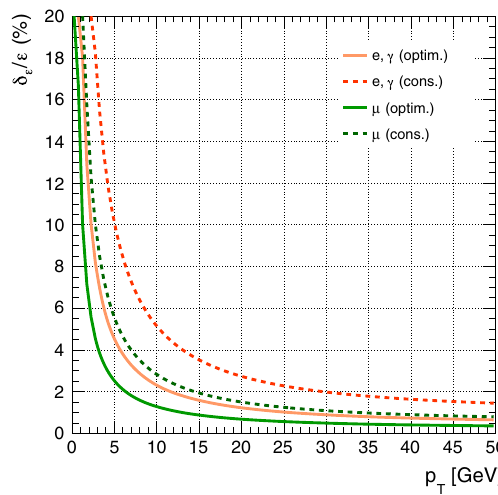
Fig. 4.4 The uncertainty on the reconstruction efficiency of electrons, photons and muons as a function of transverse momentum. An optimistic (solid) and a conservative (dashed) scenario are considered